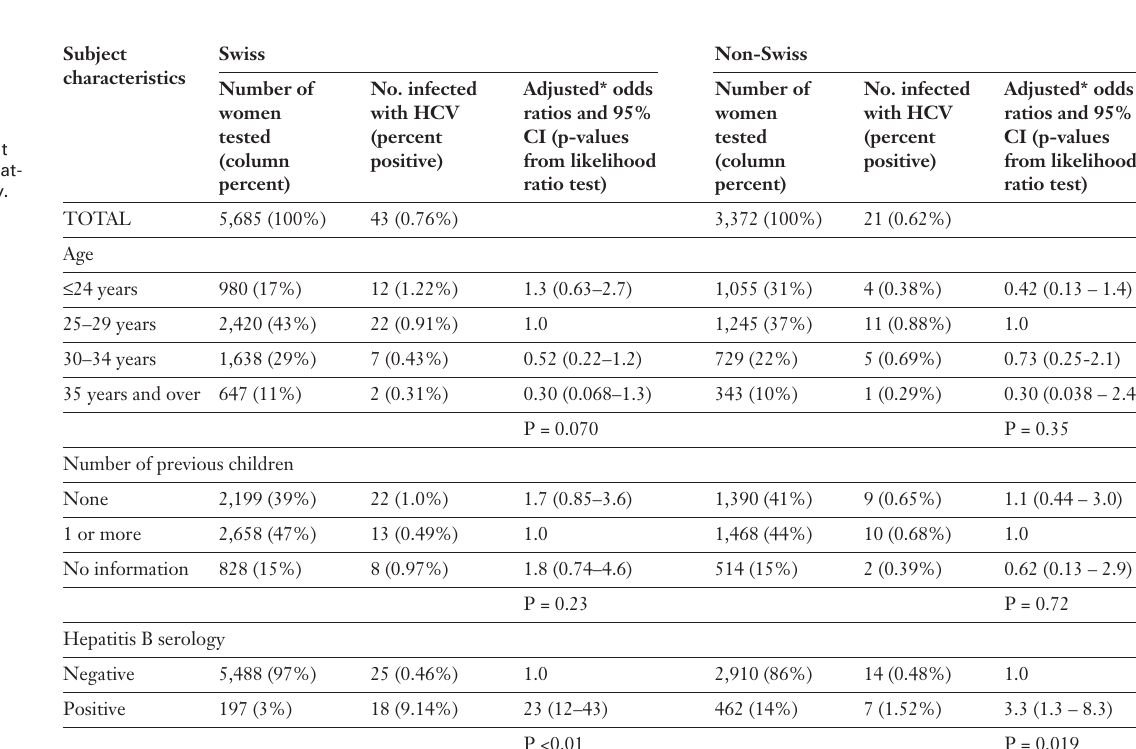
Factors associated with being HCV seropositive in a sample of pregnant women: results strat- ified for